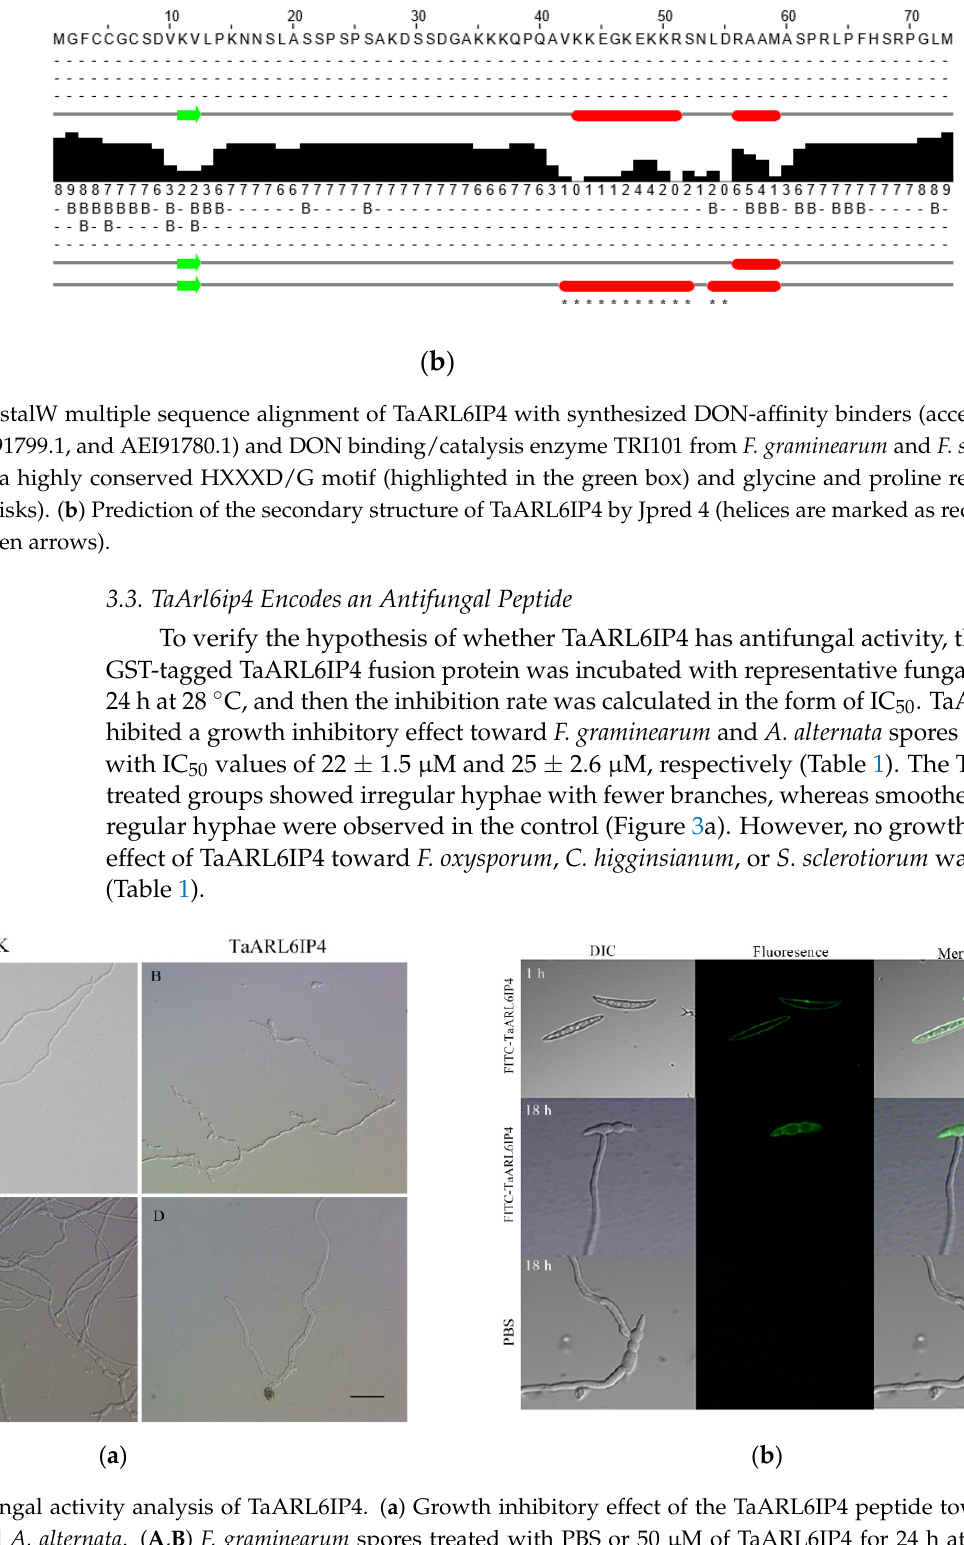
Figure 3. Antifungal activity analysis of TaARL6IP4. ( a ) Growth inhibitory effect of the TaARL6IP4 peptide toward F. graminearum and A. alternata . ( A , B ) F. graminearum spores treated with PBS or 50 µM of TaARL6IP4 for 24 h at 28 °C, respectively. ( C , D ) A. alternata spores treated with PBS or 50 µM of TaARL6IP4 for 24 h at 28 °C, respectively (Bar = 40 µm). ( b ) TaARL6IP4 inhibited the germination of F. graminearum spores by targeting the fungal plasma membrane. FITC-ahx-labeled TaARL6IP4 peptide (50 µM) and PBS (control) were used for the treatment of F. graminearum 5035 spores in the dark at 25 °C for 1 and 18 h, respectively (Bar = 20 µm).